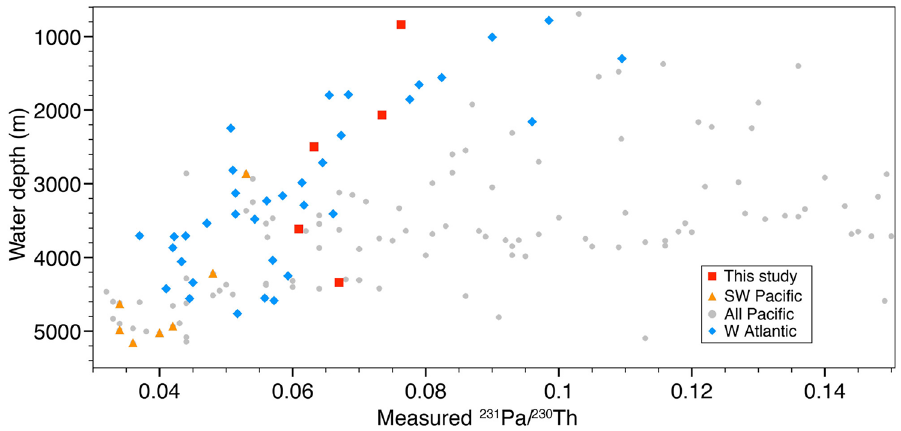
Figure 1. Holocene 231 Pa/ 230 Th from the Pacific (grey dots) 15 , the SW-Pacific (orange triangles 15 ; red squares, this study), and the W Atlantic (blue diamonds; Table S1). Decreasing 231 Pa/ 230 Th with water depth in the W Atlantic (blue) is interpreted as an imprint of AMOC, while in the Pacific (grey) a similar correlation is observed only for the SW region (orang, red).